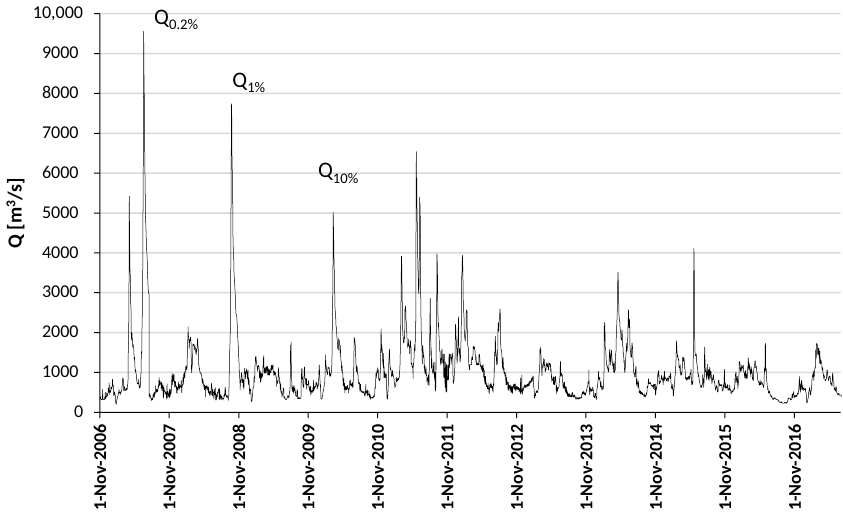
Figure 5. Flow hydrograph in Włocławek in